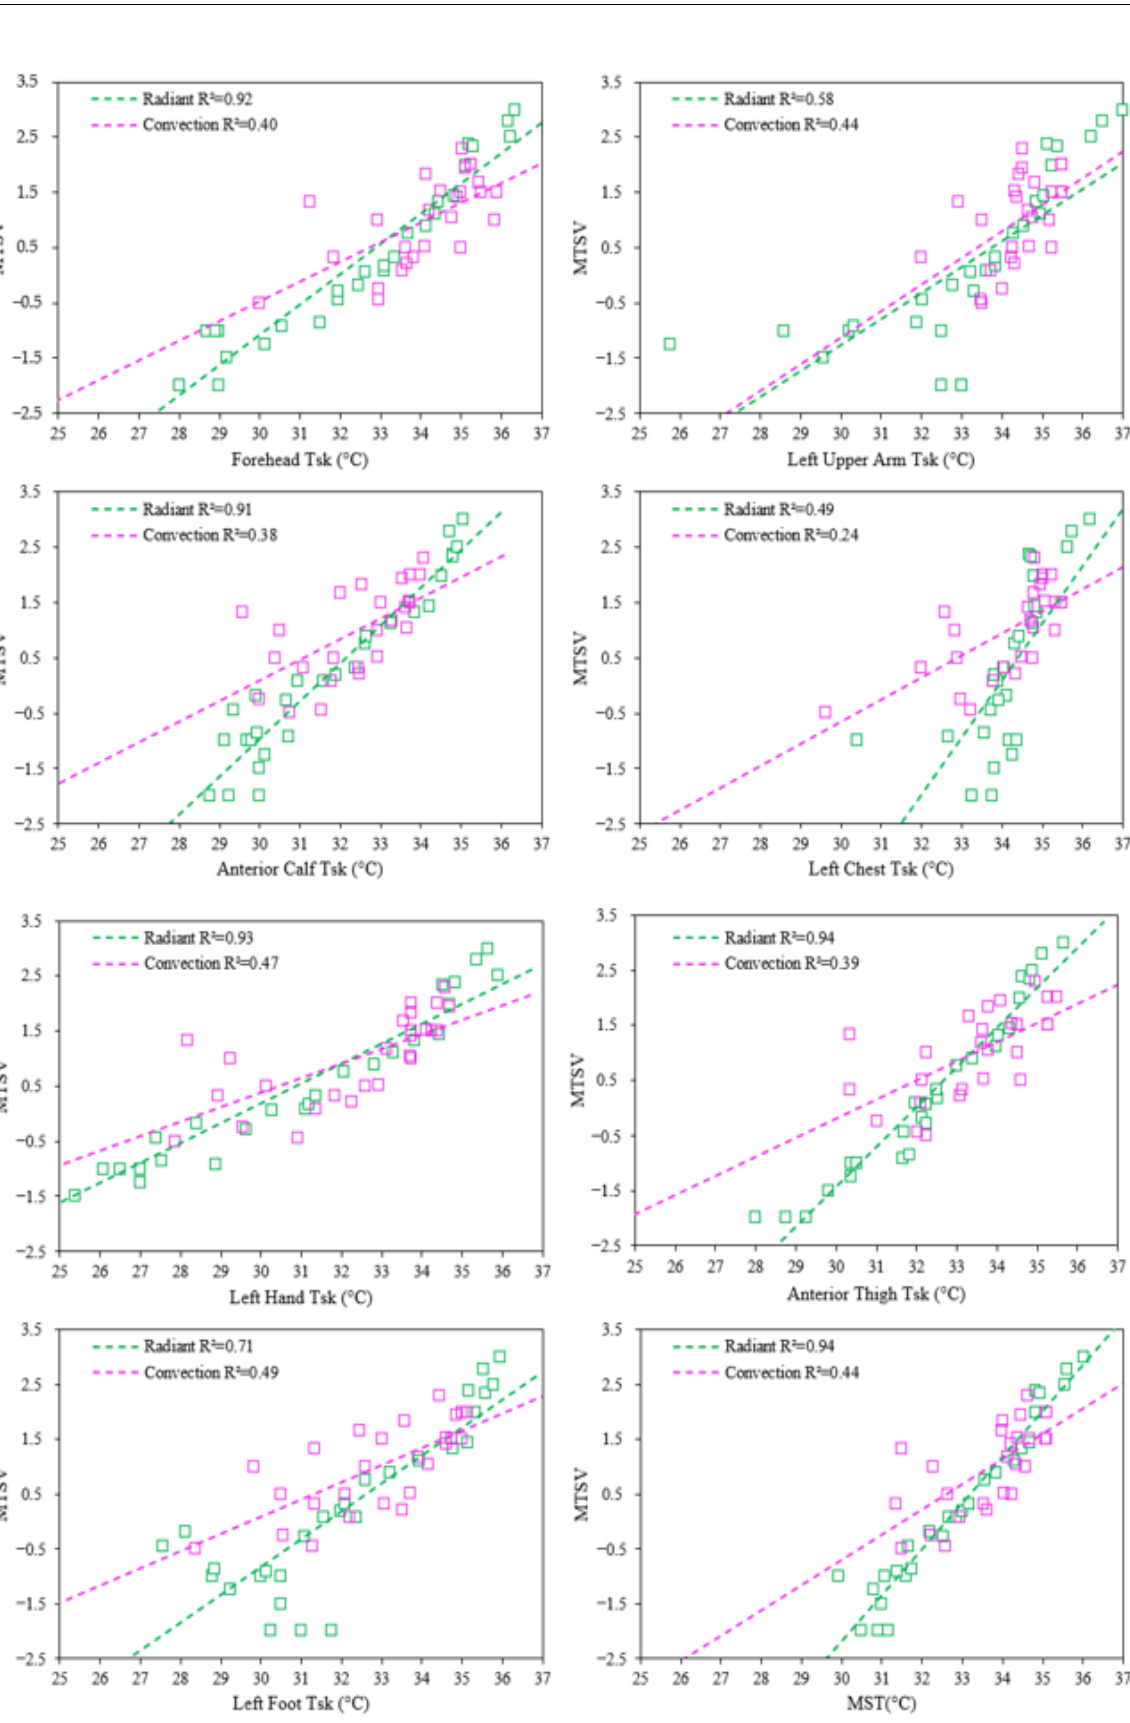
Figure 9. Thermal sensation and local skin temperature regression analysis.